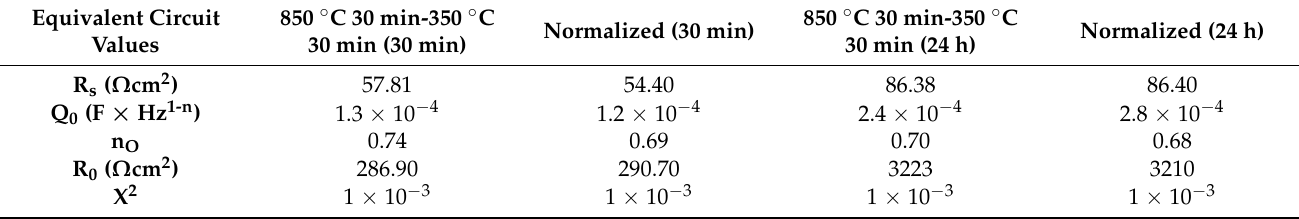
Figure 14. Equivalent circuit used for the fitting of EIS data. Table 5. Results of the fitting of the experimental data with the equivalent circuit of Figure 14 for the material austempered at 350 °C after austenitizing at 850 °C and in normalized condition.